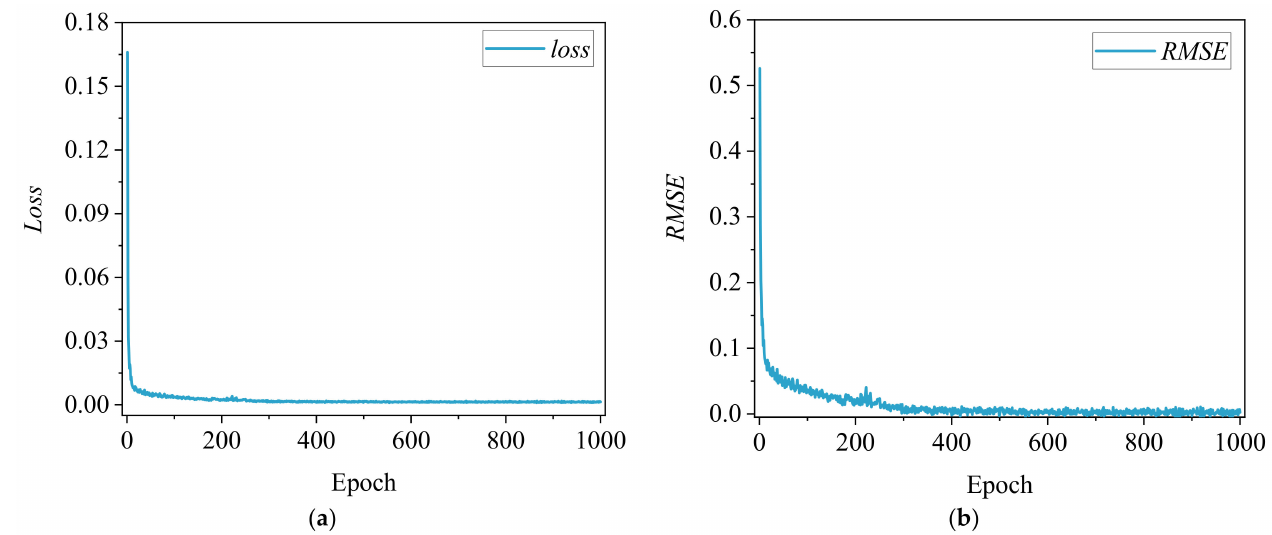
Figure 4. The training progress of the LSTM mode: ( a ) training loss; ( b ) RMSE .